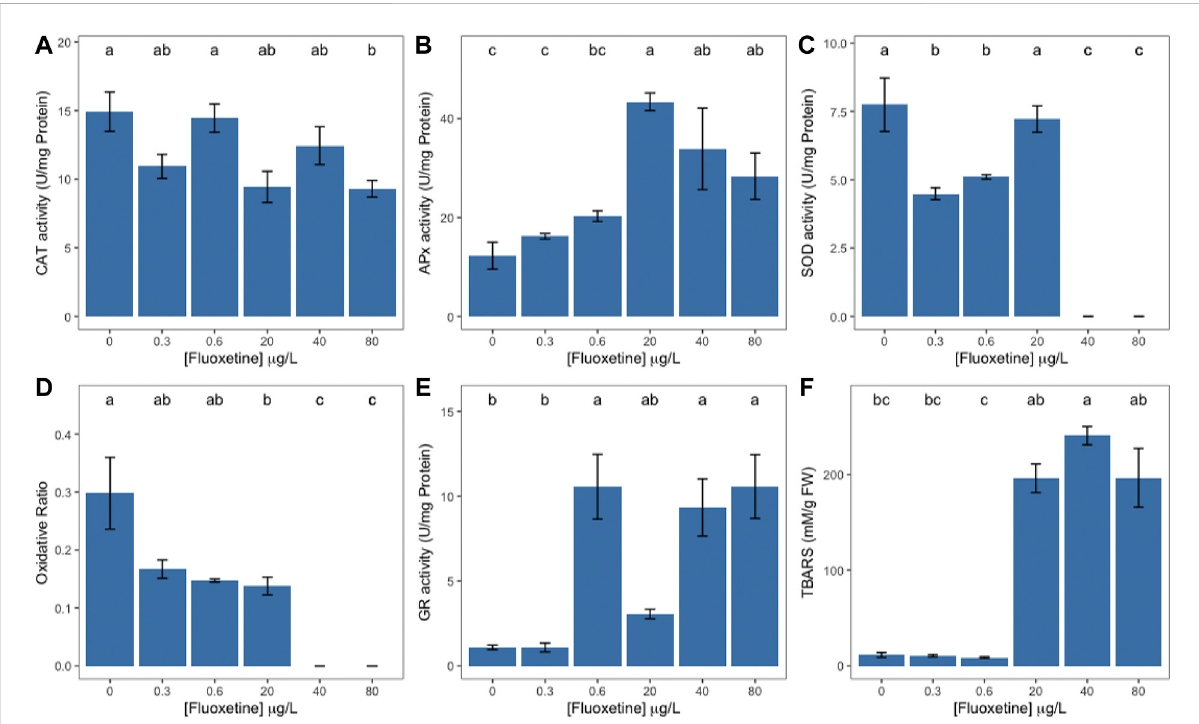
FIGURE 4 Ulva lactuca oxidative stress enzyme activity and lipid peroxidation products following a 48-h exposure to different fl uoxetine concentrations. (A) Catalase (CAT). (B) Ascorbate Peroxidase (APx). (C) Superoxide Dismutase (SOD). (D) Oxidative ratio. (E) Glutathione reductase (Gr).